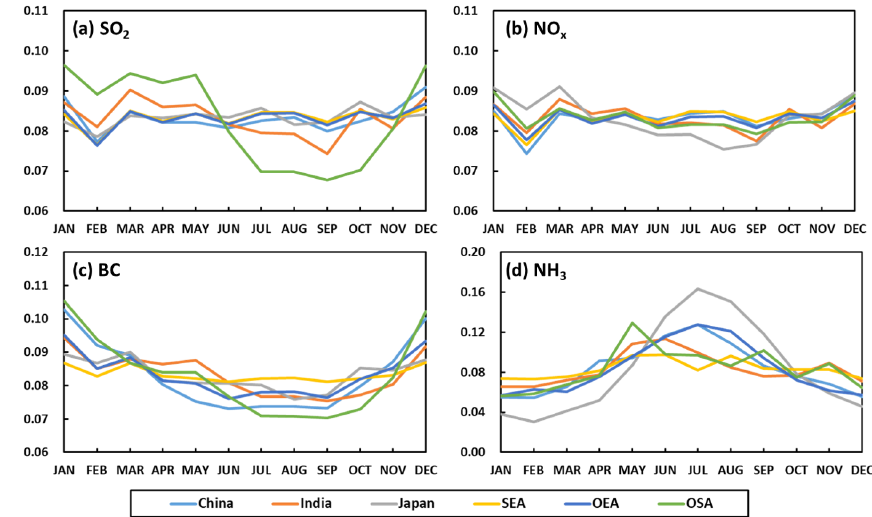
Figure 9. Monthly variations of (a) SO 2 , (b) NO x , (c) BC, and (d) NH 3 emissions for each region of Asia in 2015. See Fig. 1 for definitions of SEA, OEA, and